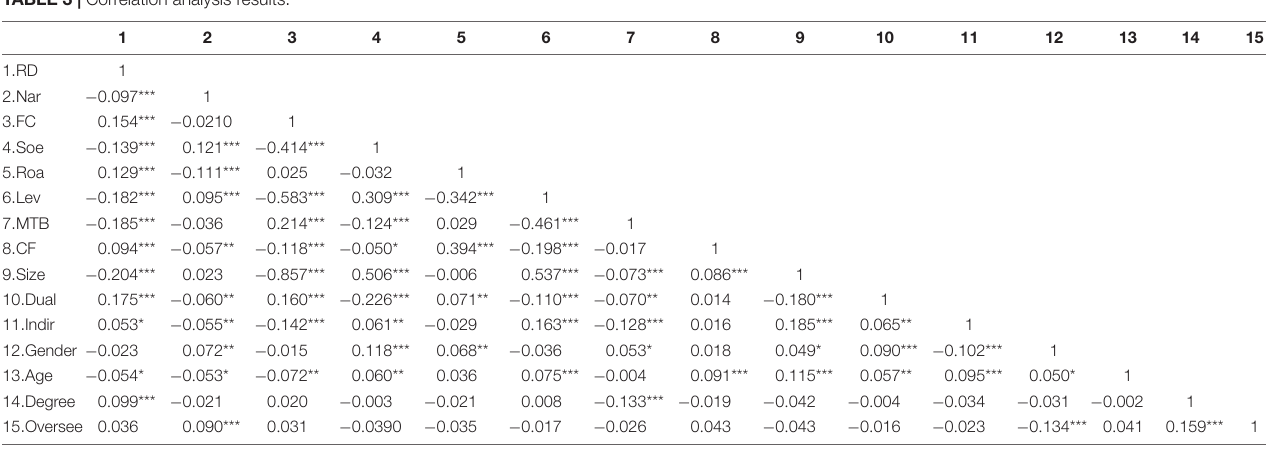
TABLE 3 | Correlation analysis